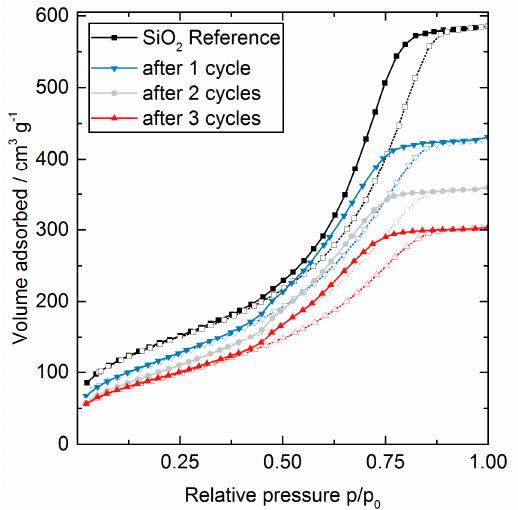
Figure 2. N 2 adsorption (hollow symbols, dotted line) and desorption (full symbols, solid line) isotherms for SiO 2 coated with AlO x via ALD using TMA and H 2 O at 200 °C. Shown are the reference SiO 2 (black, ■ ), after one cycle (blue, ▼ ), after two cycles (grey, ● ), and after three cycles (red, ▲ ). All samples gave an H 1 type hysteresis loop, with parallel adsorption and desorption branches,